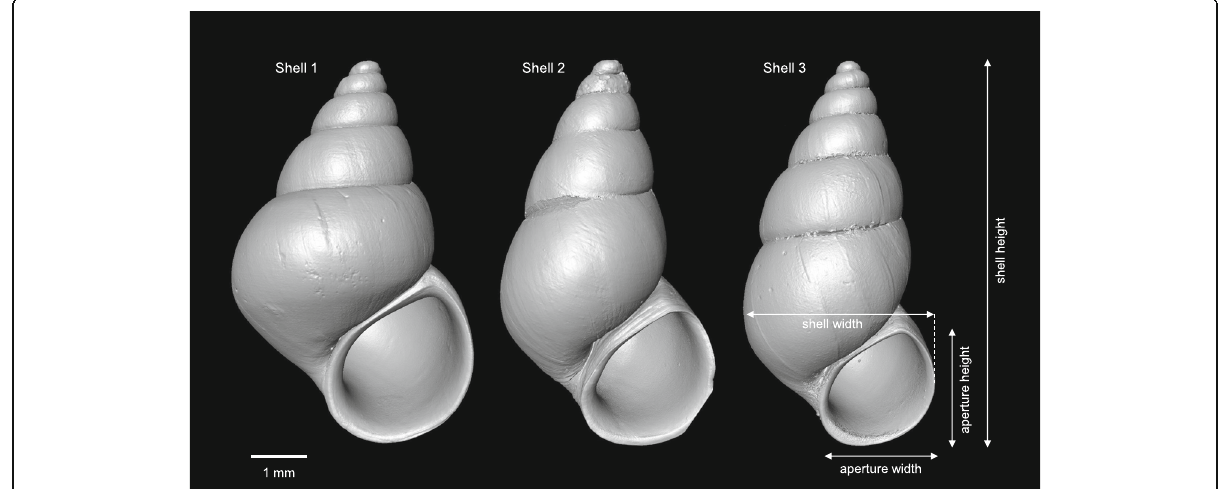
Fig. 1 Three-dimensional surface models obtained from μ CT. Shells 2 and 3 were scaled to the same height as shell